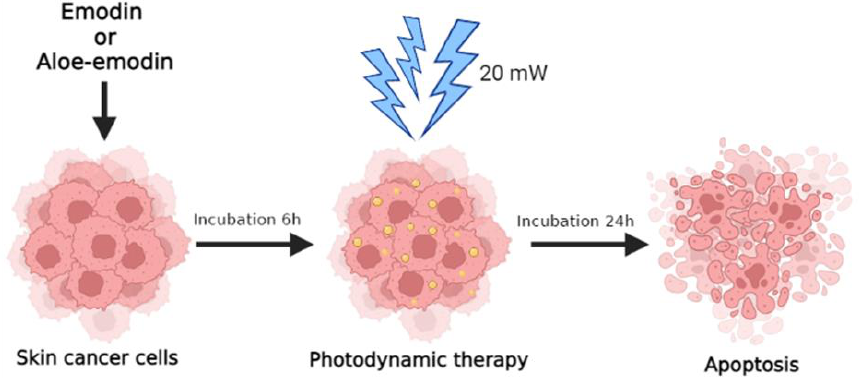
Figure 1. Scheme of emodin or aloe-emodin treated and mechanism of photodynamic